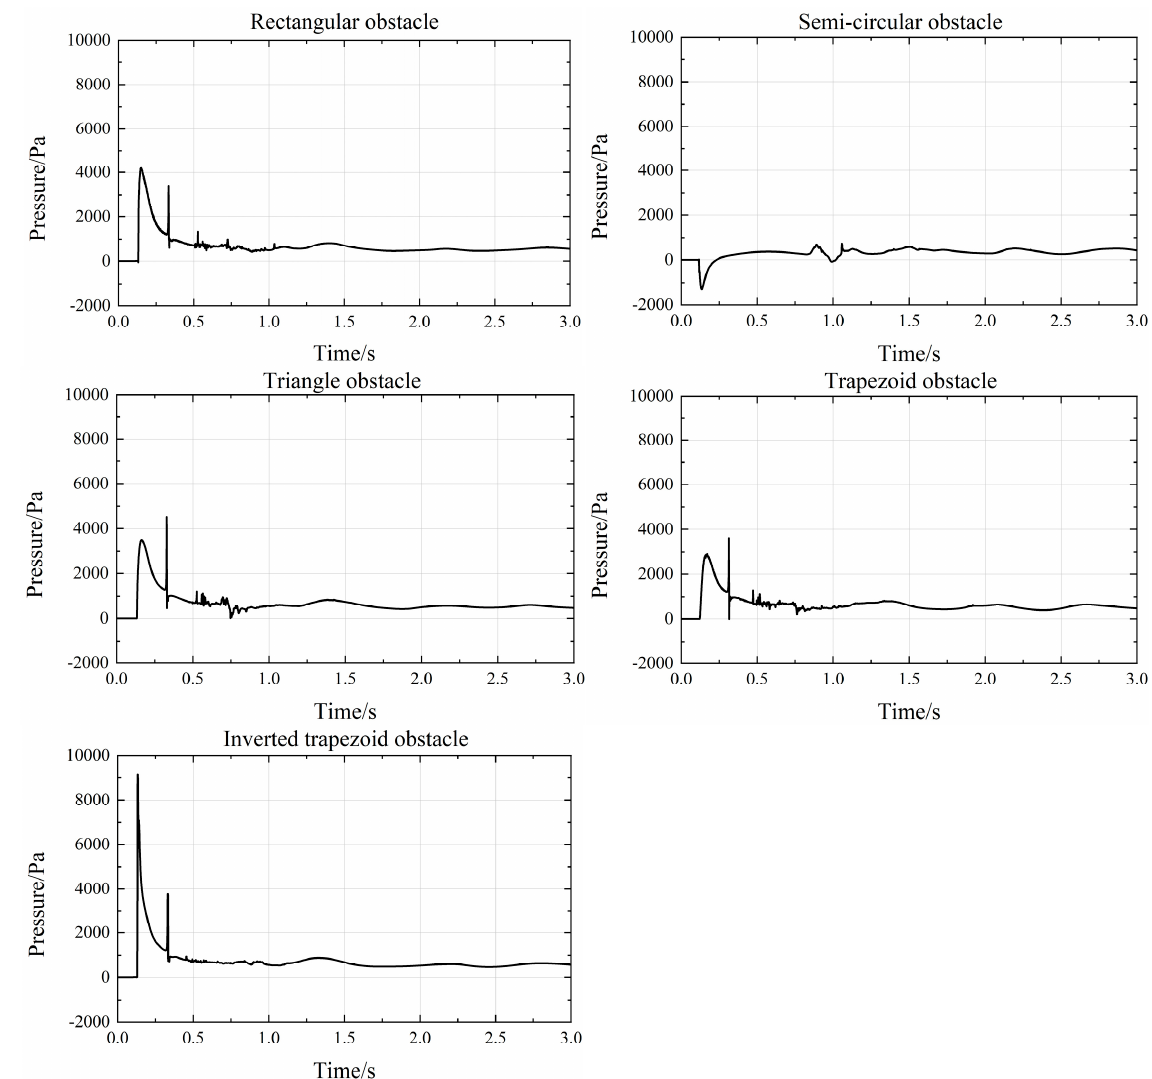
Figure 11. Pressure at test points of obstacles with di ff erent shapes.